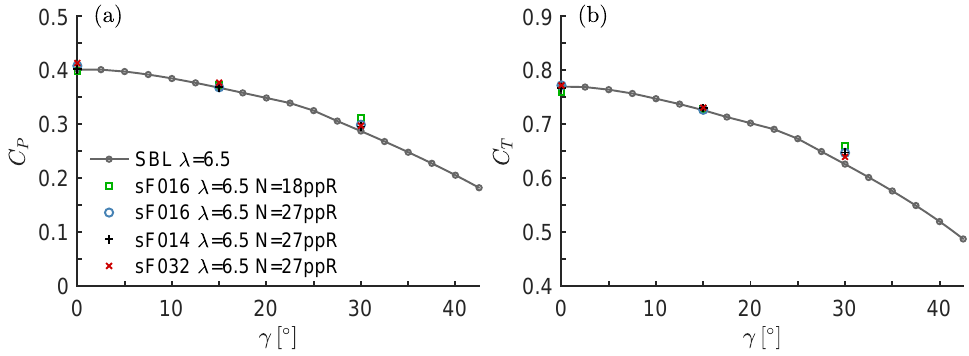
Figure 10. Comparison of measurements and numerical results for ( a ) power C P and ( b ) thrust coefficient C T as function of yaw angle γ . The legend states the flow conditions.